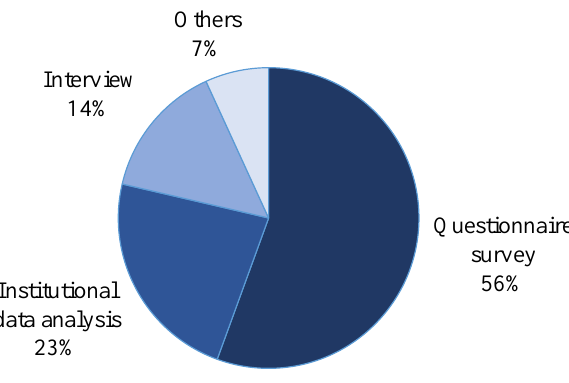
Figure 3. Proportion of the research methods used in the